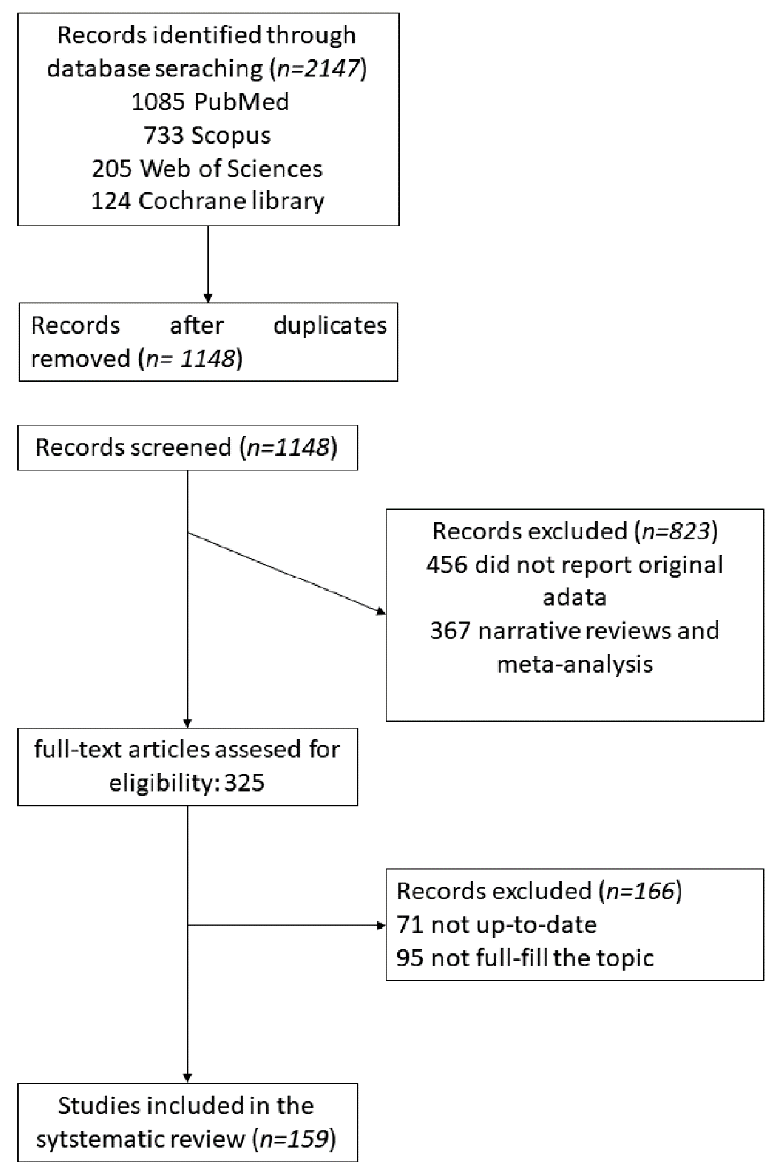
Figure 1. Data selection following eligibility criteria accordingly to the reviewed topic.